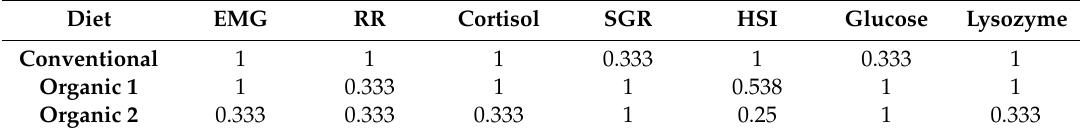
Table 7. Diagnostic frame of the scores obtained for the three diets respect to each criterion (parameter) by means of the NSFDSS. These scores are the same for Hypothesis 1 and Hypothesis 2.